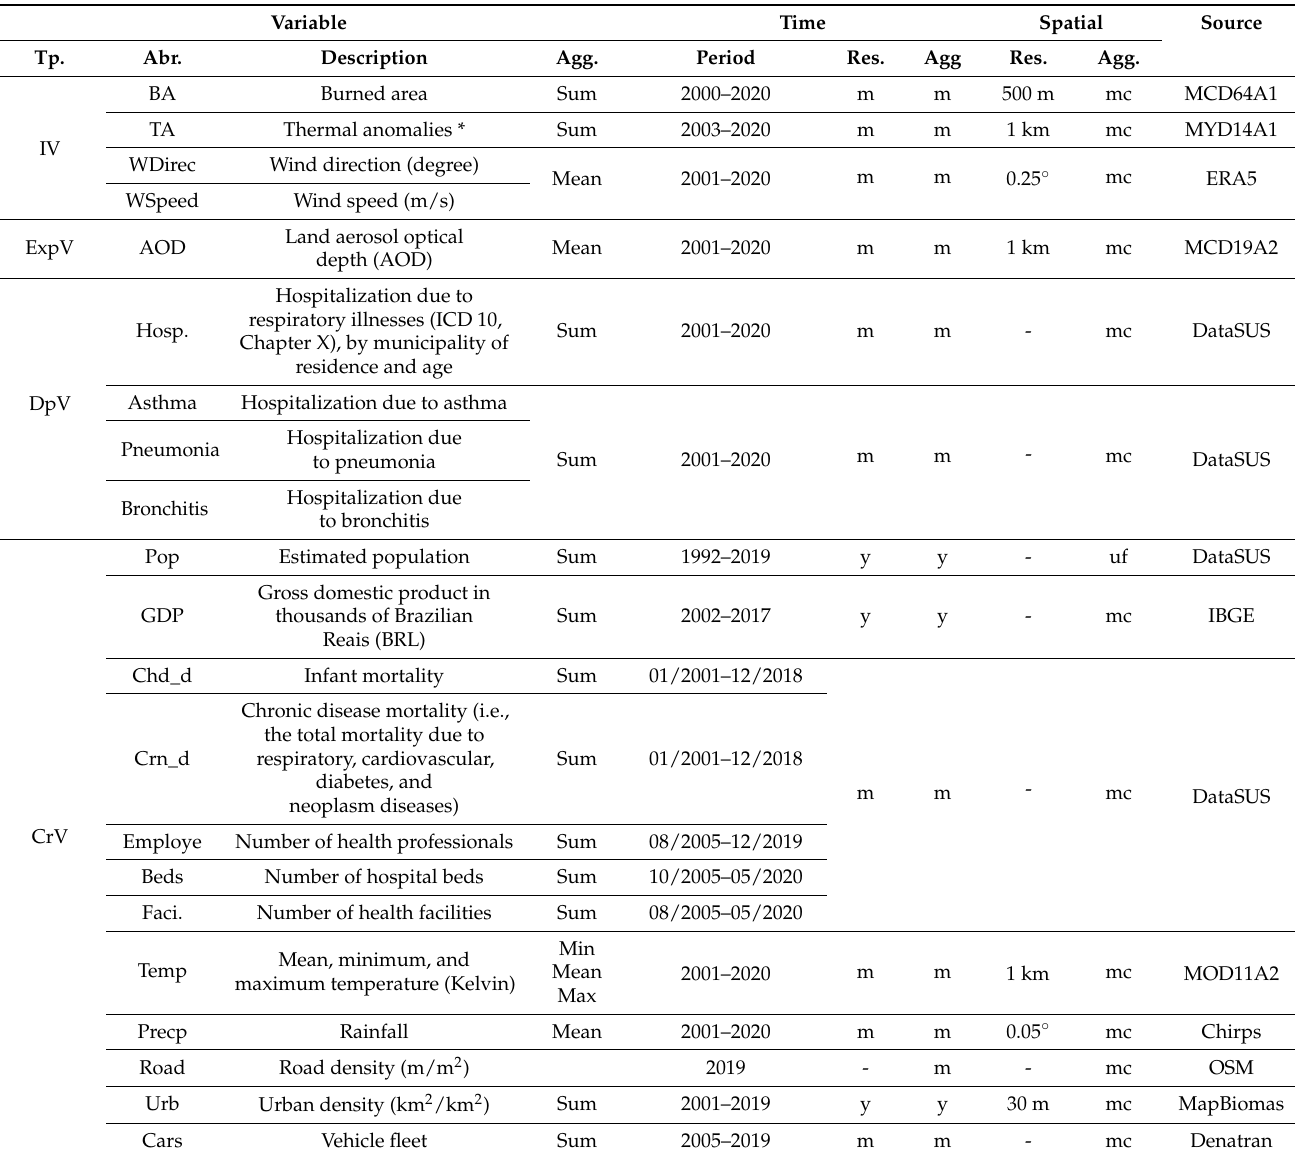
Table 1. Variables’ description and